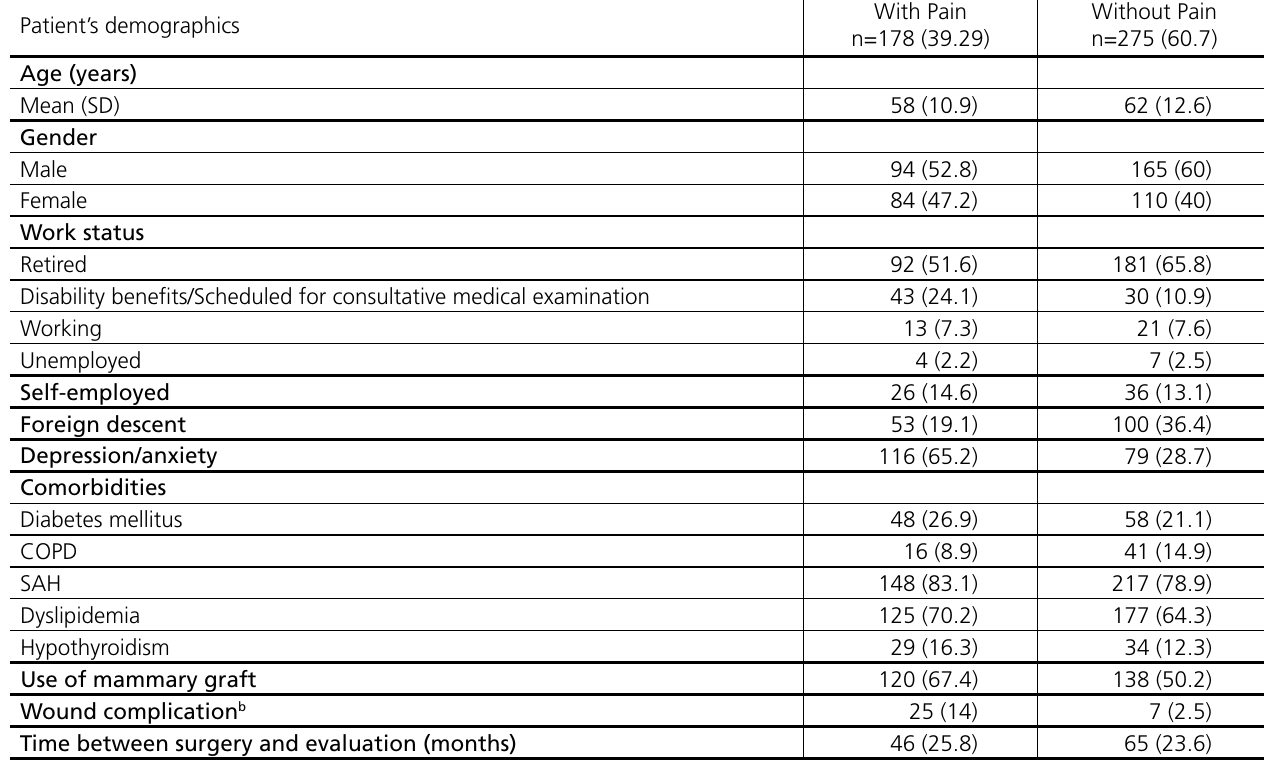
Table 2. Factors associated with the development of CPSP a .